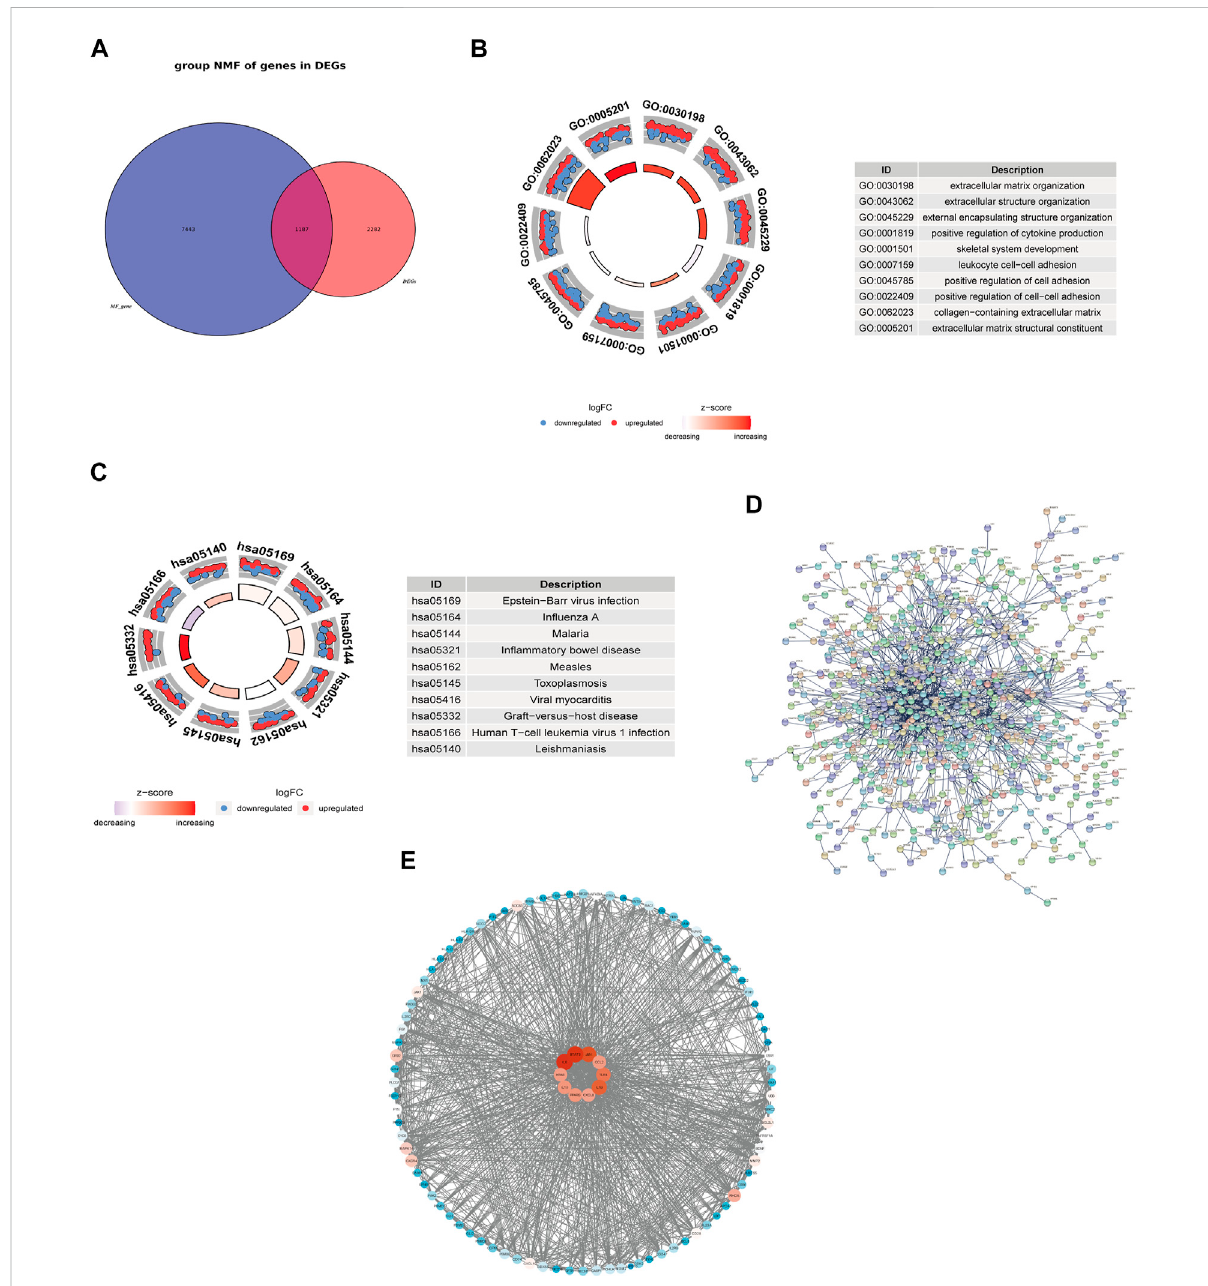
FIGURE 2 Functional enrichment analysis and exploring the interaction of fi brosis-related DEGs. Venn Diagram showed the intersection of DEGs and fi brosis-related genes (A) . GO enrichment (B) and KEGG pathway enrichment results (C) . PPI network of the interaction of fi brosis-related DEGs (D) . PPI network of the top 100 genes and the top 10 genes with the highest degrees (E)